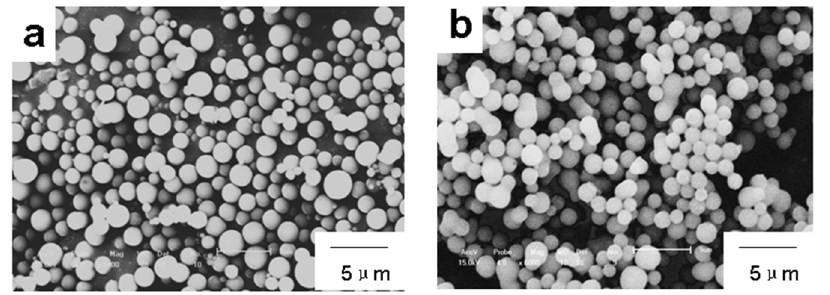
Figure 3. SEM images of polymer microspheres prepared when the molar ratio of HCCP to bi- was 1:2: ( a ) 6FPZF micro-nanospheres; ( b ) 3FPZF micro-nanospheres.